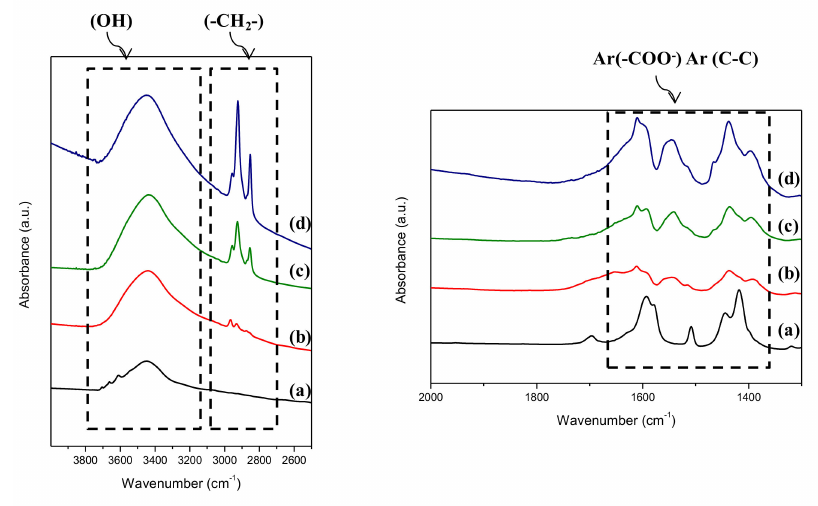
Figure 6. Infrared (IR) spectra: ( a ) MIL-53(Al), ( b ) Al-ITQ-EB, ( c ) Al-ITQ-HB and ( d )